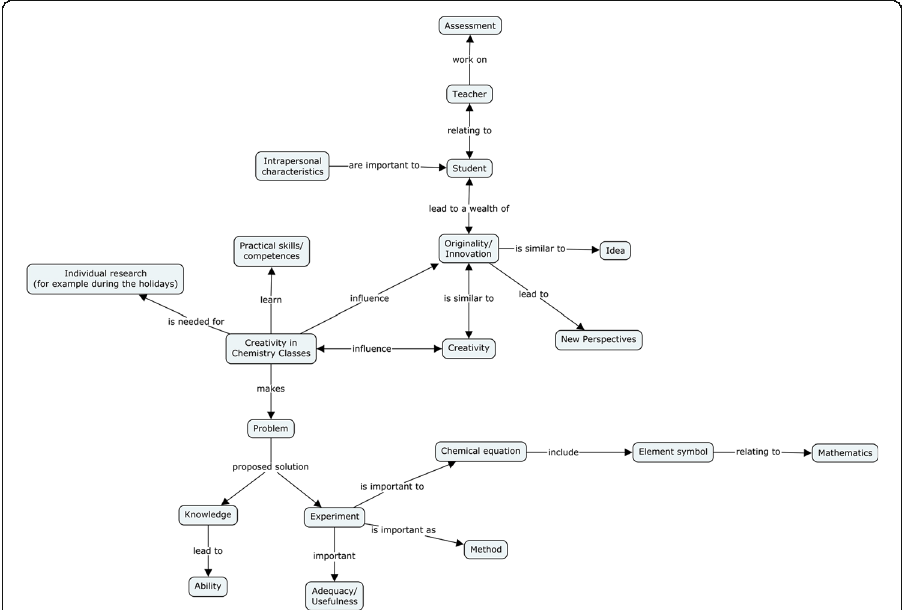
Fig. 3 Example of a concept map of a Japanese student teacher. Here, no centre can be identified. There are two network structures around the terms “ Originality/innovation ” and “ Student ” but only because of mutual links with the same linking phrases. Star structures are created around the term “ Creativity in Chemistry Classes ” including two less connected terms with only one ingoing link. There are six other less connected terms with one ingoing or outgoing